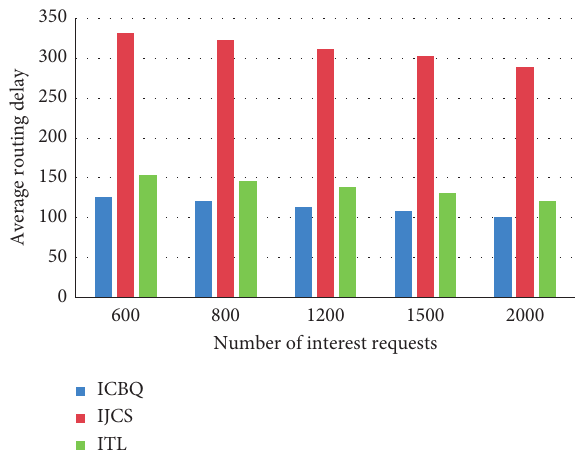
Figure 3: The average routing delay (ms) among ICBQ, IJCS, and ITL.